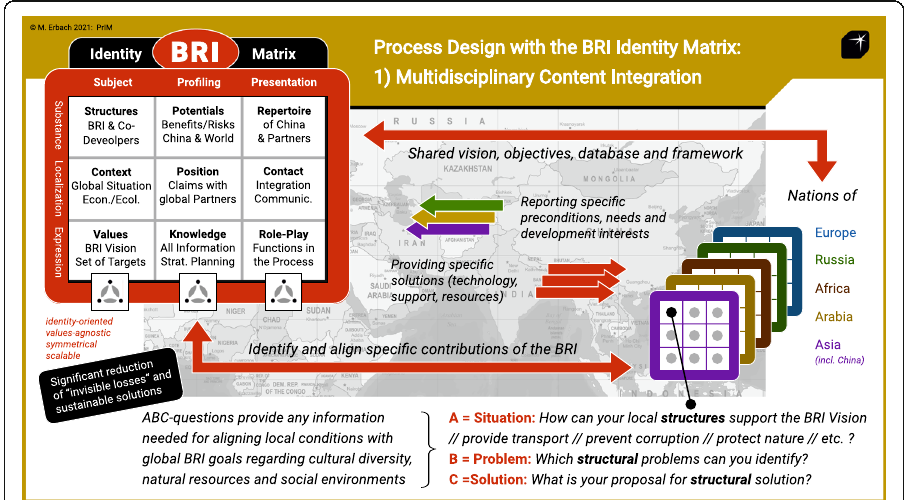
Fig. 7 Multidisciplinary content integration with the BRI Identity